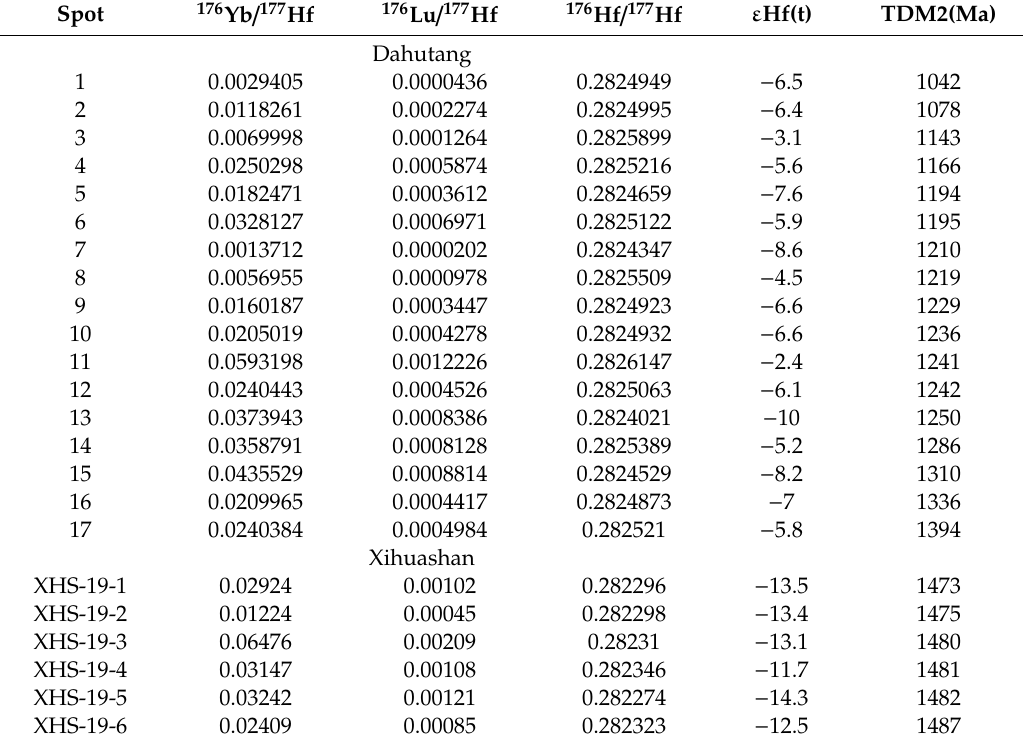
Table A2. Zircon Hf isotope data of the Dahutang and Xihuashan